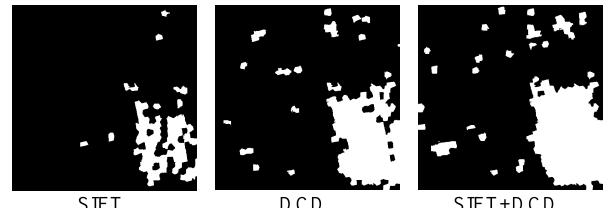
Figure 4. The change detection results of “the predictive mean” for different superpixel descriptors.